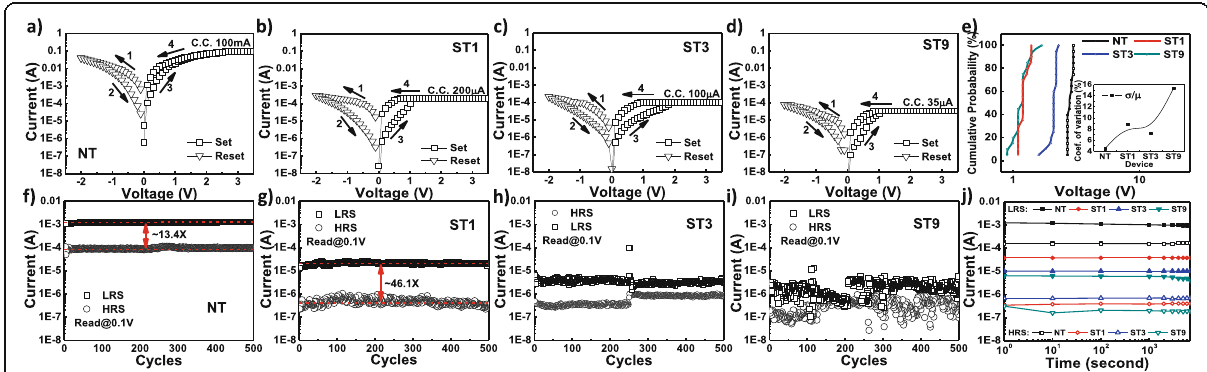
Fig. 3 Typical I – V curves of ( a ) control, ( b ) ST1, ( c ) ST3, and ( d ) ST9 devices. e Cumulative probability plot of set voltage (Vset). Endurance characteristics of ( f ) control, ( g ) ST1, ( h ) ST3, and ( i ) ST9 devices. j Room temperature retention characteristics of all devices. Inset in ( e ) shows the coefficient of variation of the Vset distribution. Each data point in ( e ) represents the 25 consecutive